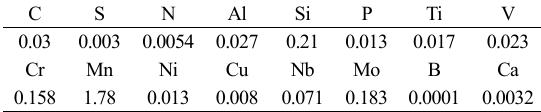
Table 1. Chemical composition of the API 5L X80 steel pipe (% mass)